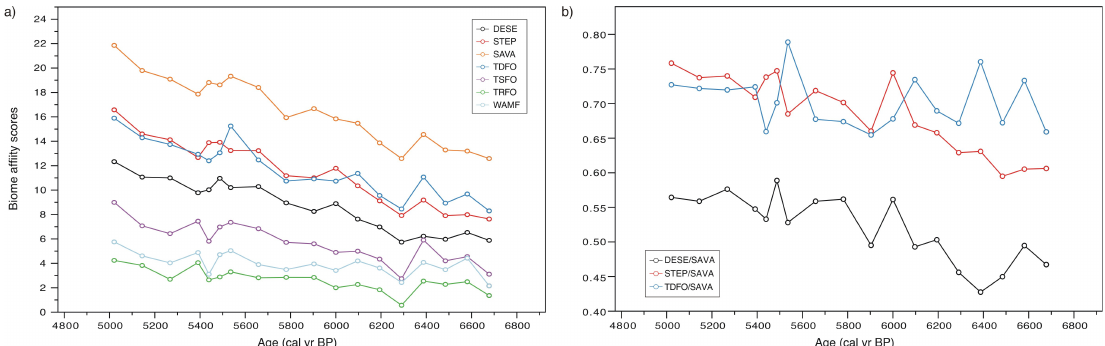
Fig. 6. Results from biomization method applied on fossil pollen data: (a) Biome affinity scores and (b) scores from drier biomes normalized by SAVA values, derived from the LT1 pollen data set, Lake Chad (DESE: desert; STEP: steppe; SAVA: savanna; TDFO: tropical dry forest; TSFO: tropical seasonal forest; TRFO: tropical rain forest; WAMF: warm mixed-forest).